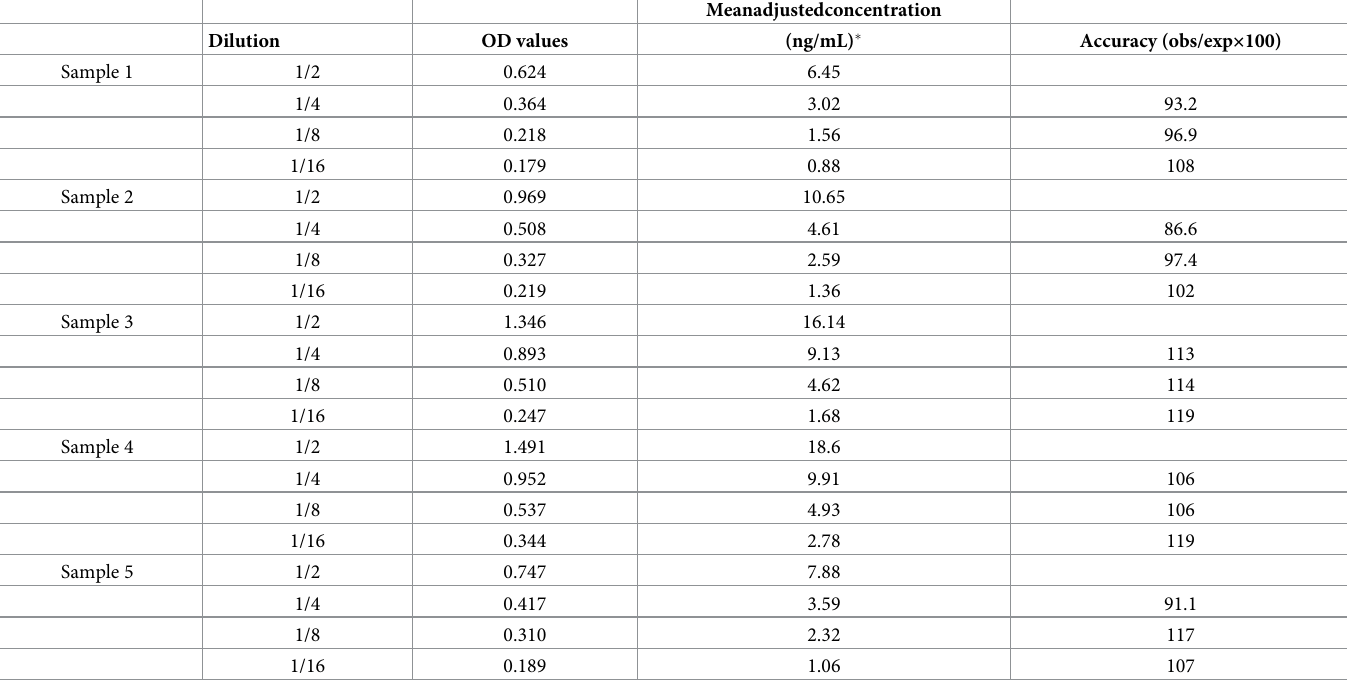
Table 3. Dilution linearity of AroCell TK 210